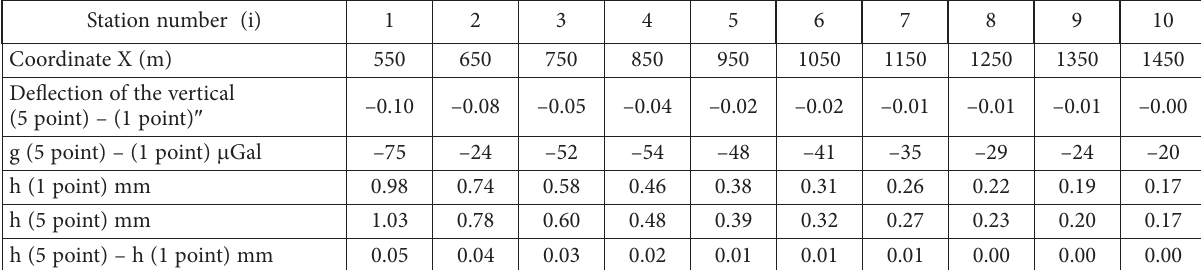
Table 2. Differences in the plumb line, gravity and leveling excesses, one-point and five-point approximated model of the cone for the leveling Station number (i)